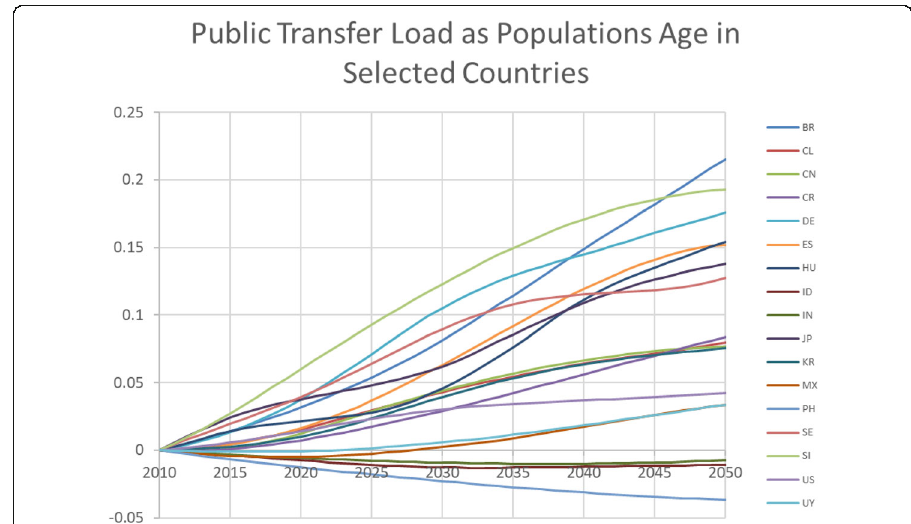
Fig. 9 Change in public transfer load as populations age in selected countries. Note: Public transfer load is the projected increase in public transfer budget deficit assuming base period age profiles of taxes and benefits are fixed and the population age distribution varies as projected by the United Nations Population Division (2013). Load is expressed as a proportion of projected aggregate consumption assuming the age profile of consumption is also fixed at base period. Source: Calculated from National Transfer Account age